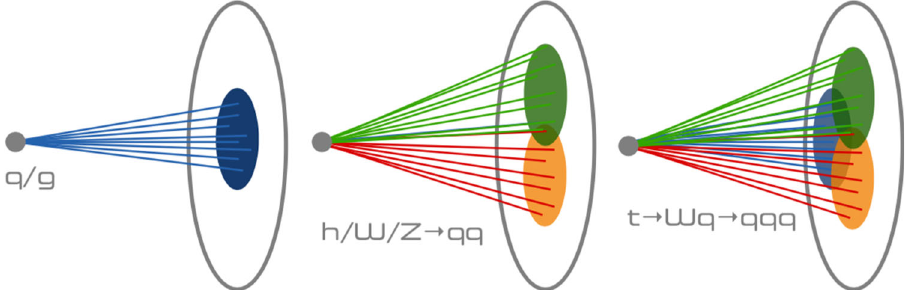
Fig. 1 Pictorial representations of the different jet categories consid- ered in this paper. Left: jets originating from quarks or gluons produce one cluster of particles, approximately cone-shaped, developing along the flight direction of the quark or gluon that started the cascade. Cen-